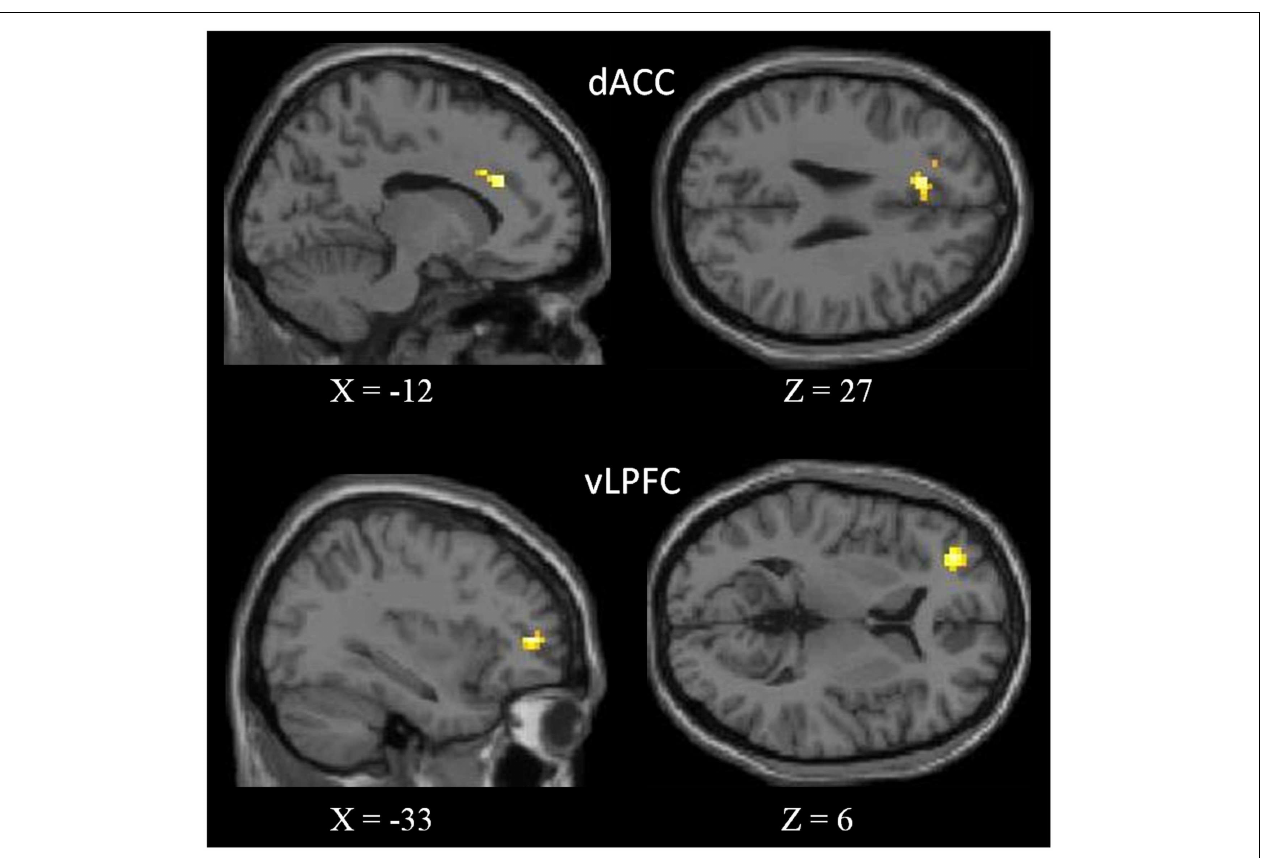
superimposed to a single subjectT1-weighted image normalized to the MNI stereotaxic space. Results are significant at a threshold of p < 0.01 (uncorrected) with an extended threshold of k = 10.